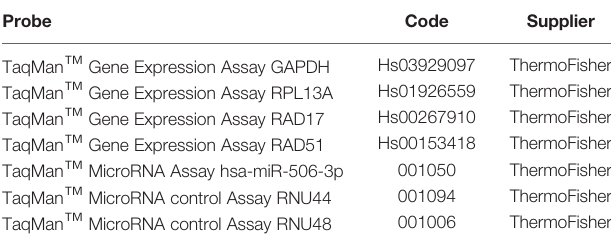
TABLE 2 | List of the qRT-PCR probes used.